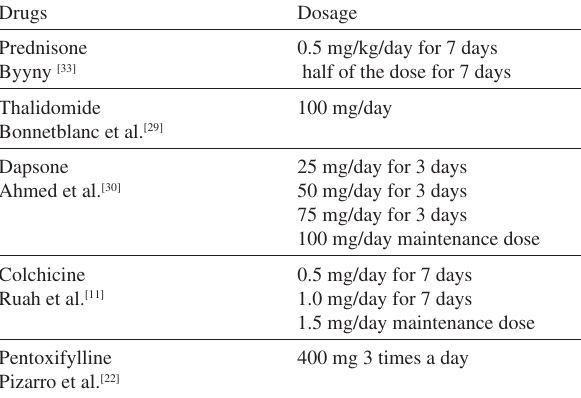
Table 1 - Therapeutic schedule Table 2 - Characteristics of the patients (n = 21)